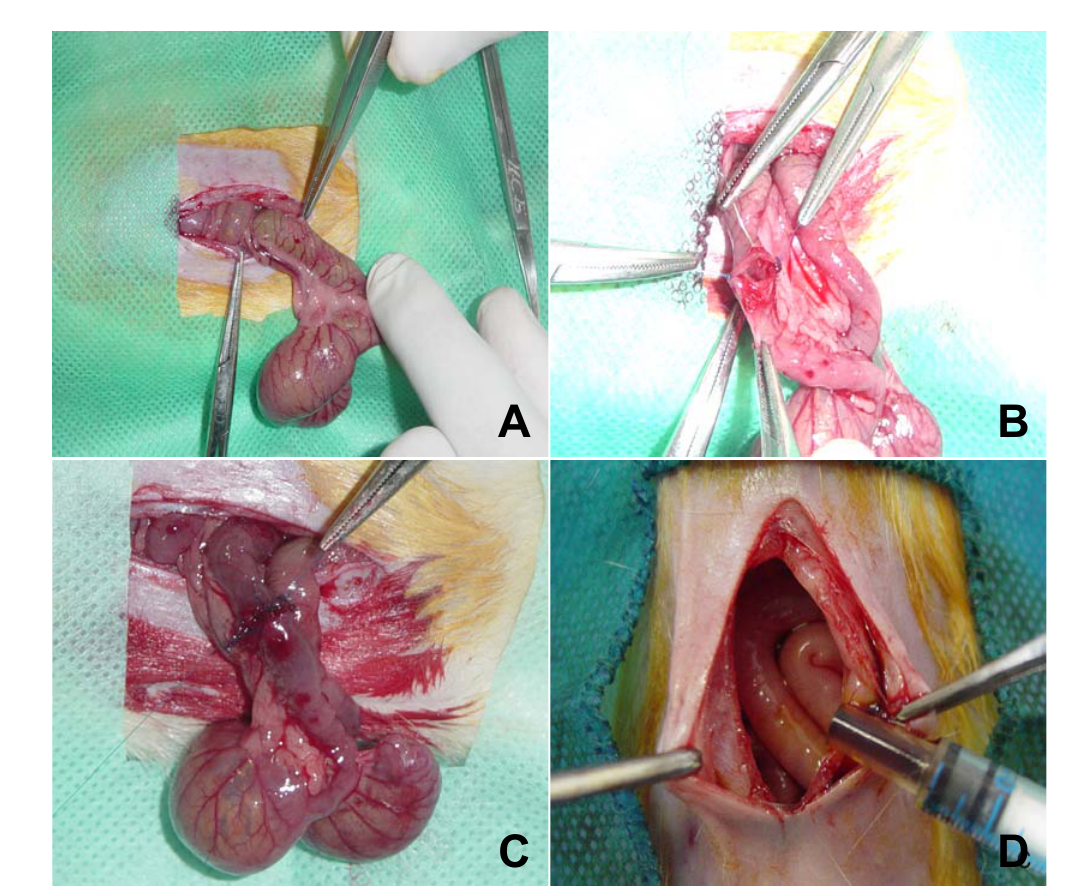
FIGURA 1 – Técnica Operatória: A – Exposição do segmento colônico, B – Colotomia e início da anastomose, C – Anastomose com - pleta, D – Aplicação intraperitoneal do